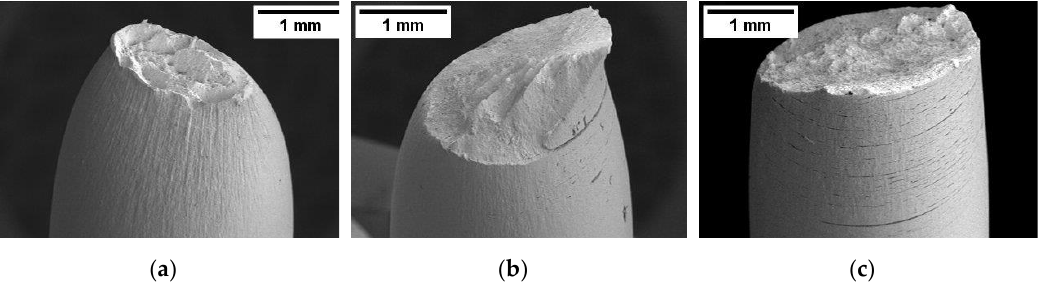
Figure 13. SEM images of the specimens of the X100 steel after the SSR test in NaCl 3.5% (strain rate 10 −6 s −1 ) ( a ) at the open circuit potential; ( b ) polarized at −1 V vs. SCE; ( c ) polarized at −2 V vs. SCE.